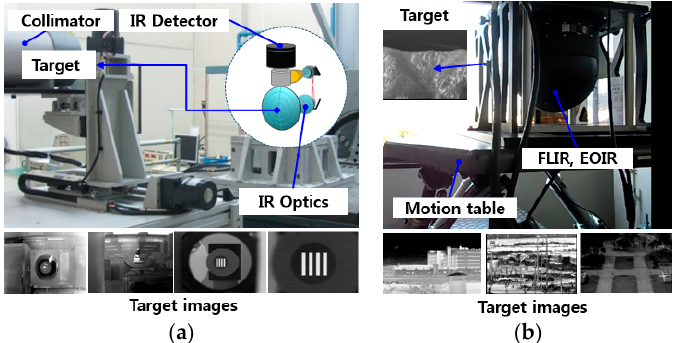
Figure 9. Experiment configurations: ( a ) An observation environment for simulation targets on a collimator with forward looking IR (FLIR) and electro-optical IR (EOIR); ( b ) an observation environment for actual targets.